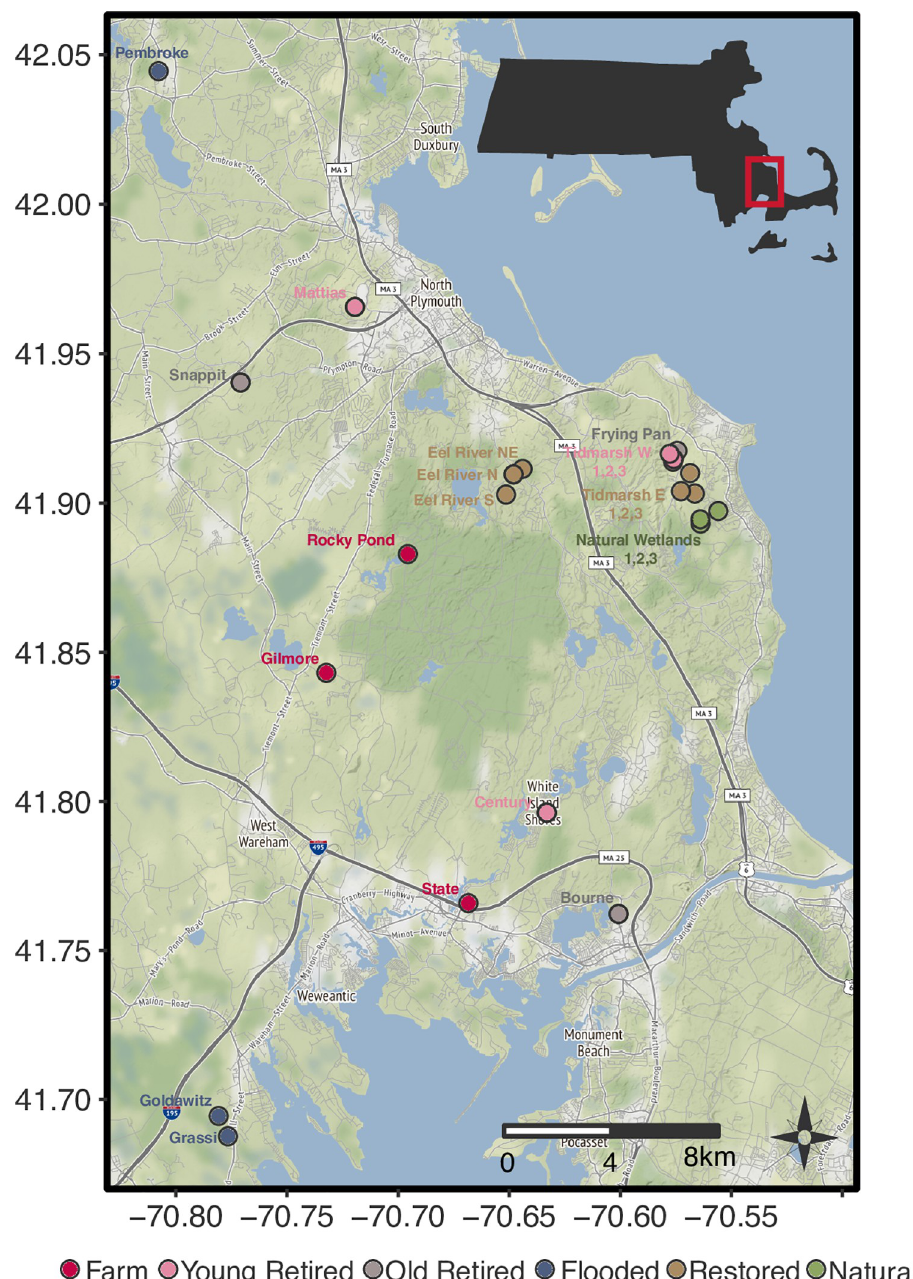
Fig 1. Map of study area. 23 sites were surveyed in southeast Massachusetts, spanning five treatments. Map tiles by Stamen Design, under CC BY 3.0. Data by OpenStreetMap (WGS-84), under ODbL. Eight soil samples (dysic, mesic Typic Haplosaprists of the Freetown series), were randomly selected at each site, spaced 30 m apart. Plants and mosses were removed from the soil surface, and soils were collected using a 1.5-cm diameter soil corer to a depth of 10 cm, and flame ster- ilized between each sample. Soil samples were homogenized in their own bags and subsampled in the field: half of each sample was flash frozen in liquid nitrogen and stored at -80˚C until DNA extraction, and the other half was stored at 5˚C for the remaining 35 soil analyses.